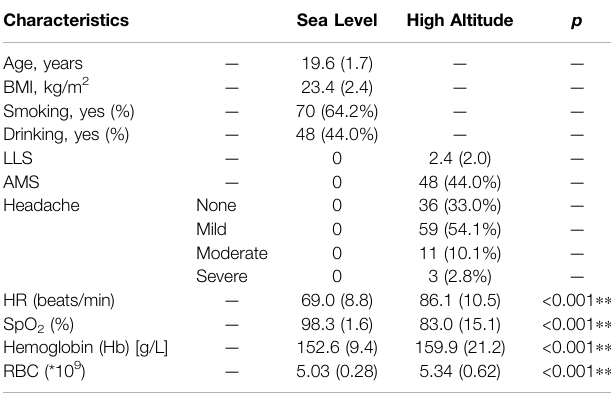
TABLE 1 | Demographic characteristics and systemic parameters of the study participants ( N = 109). Characteristics